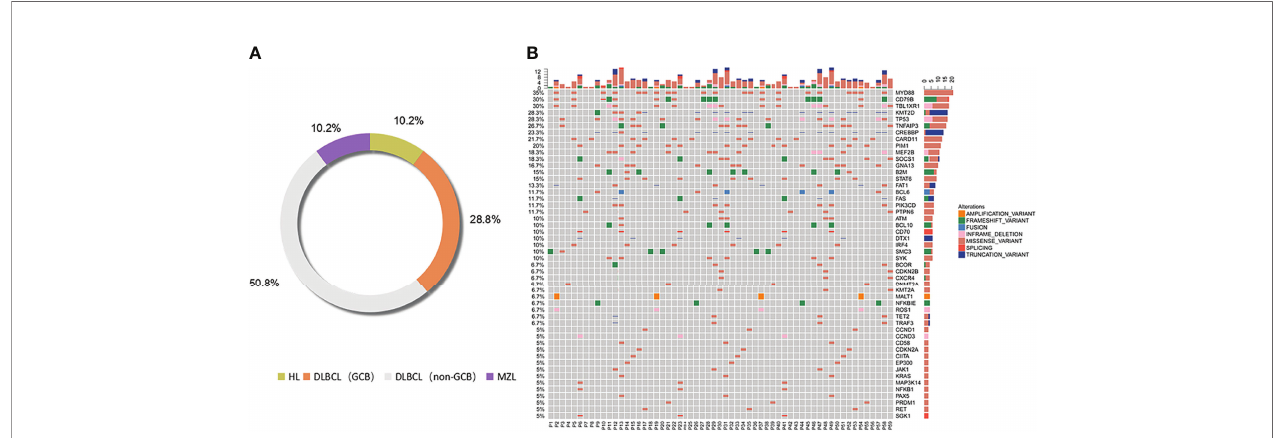
FIGURE 2 | Distribution of lymphoma subtypes. Distribution of pathological subtypes and genetic alterations of ctDNA in the total cohort. (A) Detailed distribution of pathological subtypes of 59 lymphomas. (B) Genetic alterations of ctDNA in the total cohort. HL, Hodgkin ’ s lymphoma; DLBCL, diffuse large B cell lymphoma; MZL, marginal zone lymphoma.